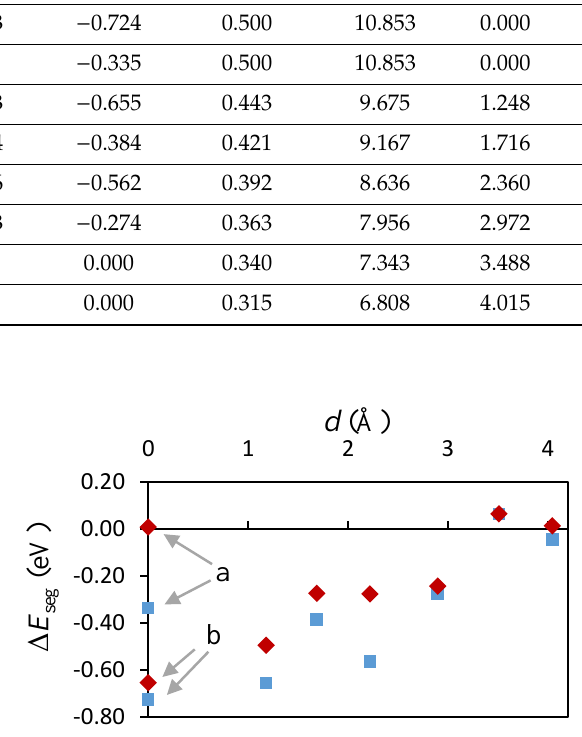
Table 1. Segregation energies Δ E seg (eV) for P and S for the atomic sites labelled in Figure 1, the respective distances ( d ) from the GB plane, coordination number of the site and volume expansion relative to the fcc single crystal (%).